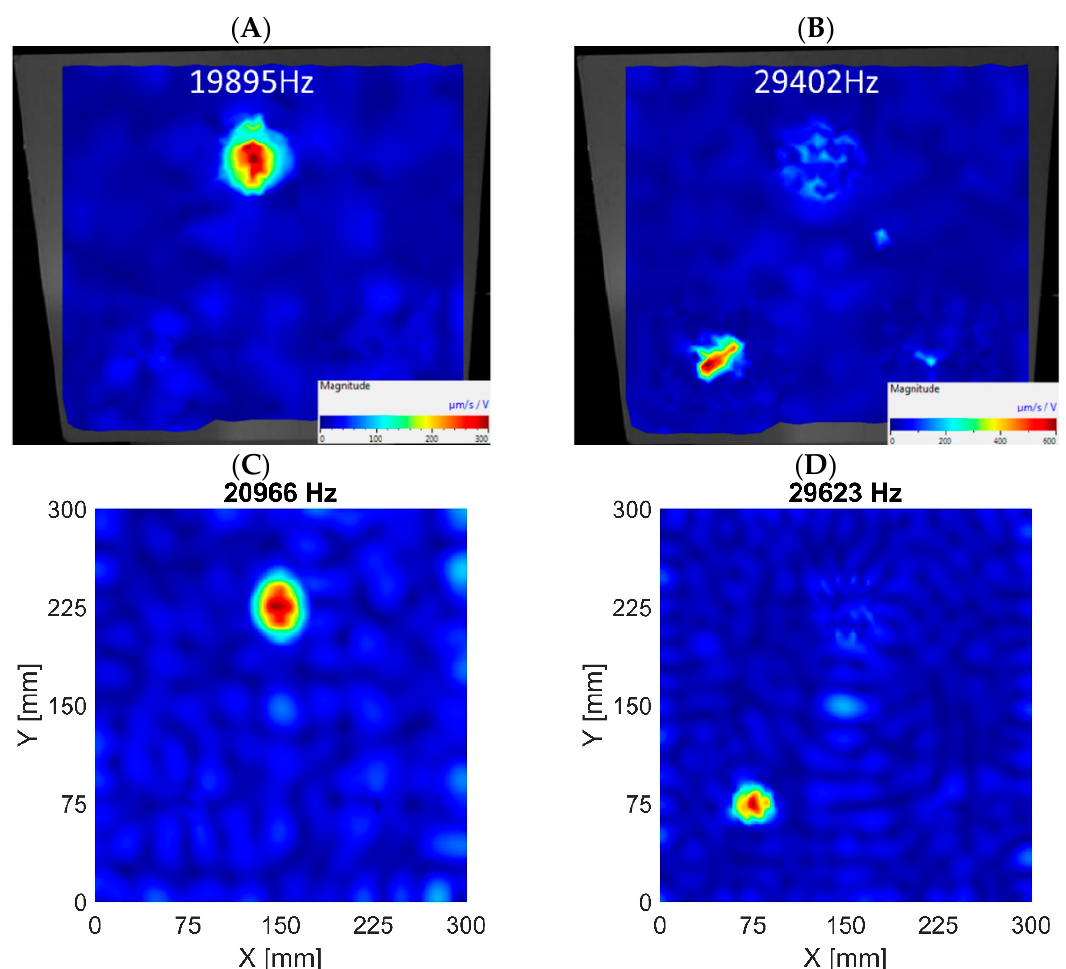
Figure 14. ‘Clear’ in-plane LDRs of FBH Ø58 mm based on experimental data ( A ) and 3D FE model results ( C ); ‘Clear’ in-plane LDRs of FBH Ø40 mm based on experimental data ( B ) and 3D FE model results ( D ).